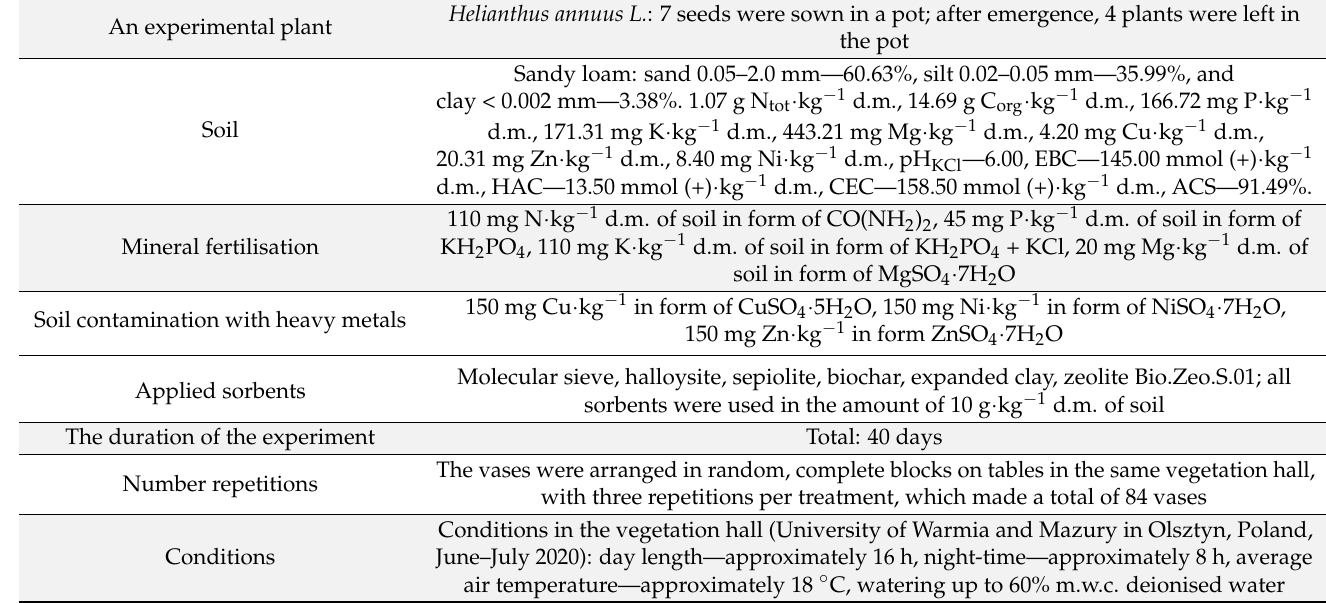
Table 1. The design of the greenhouse experiment with the sunflower. Helianthus annuus L. : 7 seeds were sown in a pot; after emergence, 4 plants were left in An experimental plant the